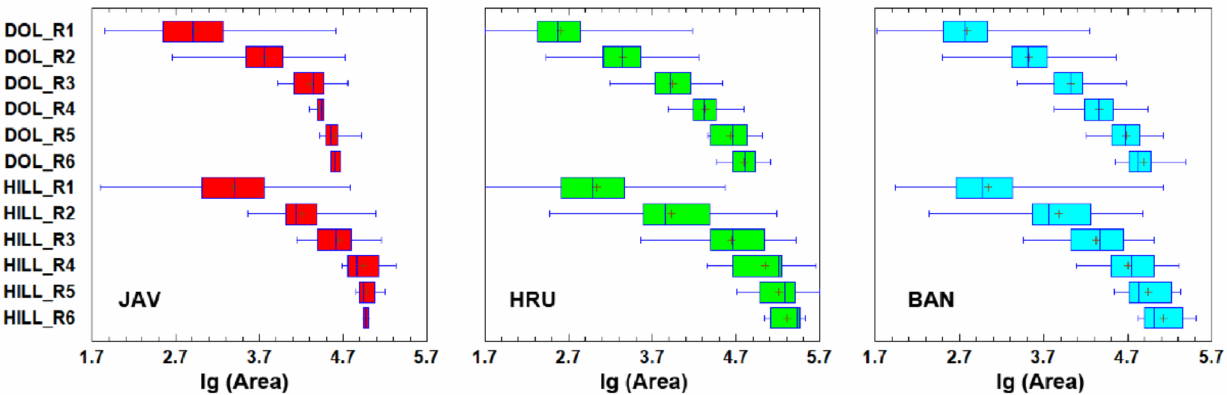
Figure 9. Box-whisker plots of doline and hill planform areas. Note that feature properties are logarithmically transformed on the x-axis. The plus signs denote the mean values of the distributions. The boxes mark the ranges between the lower and upper quartiles. JAV: Javorniki; HRU: Hrušica; and BAN: